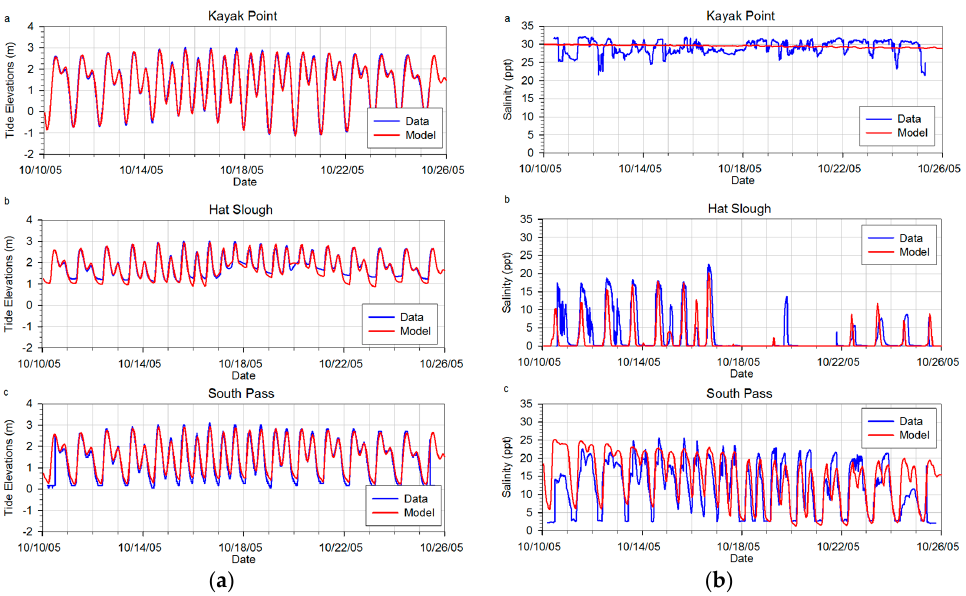
Figure 3. Comparison of predicted and measured ( a ) water surface elevations and ( b ) salinity at the Kayak Point, Hatt Slough, and South Pass stations, respectively. Table 2 provides validation error statistics comparing measured water surface elevation data to simulated results. Error statistics include the root mean square error (RMSE), mean error (ME), and mean error relative (RME) [6]. The overall root mean square error (RMSE) relative to tidal range is <10% with a negative bias of 4 cm and average RMSE of 24 cm. Table 2. Model error statistics for water surface elevation, salinity, and velocity. Station ME